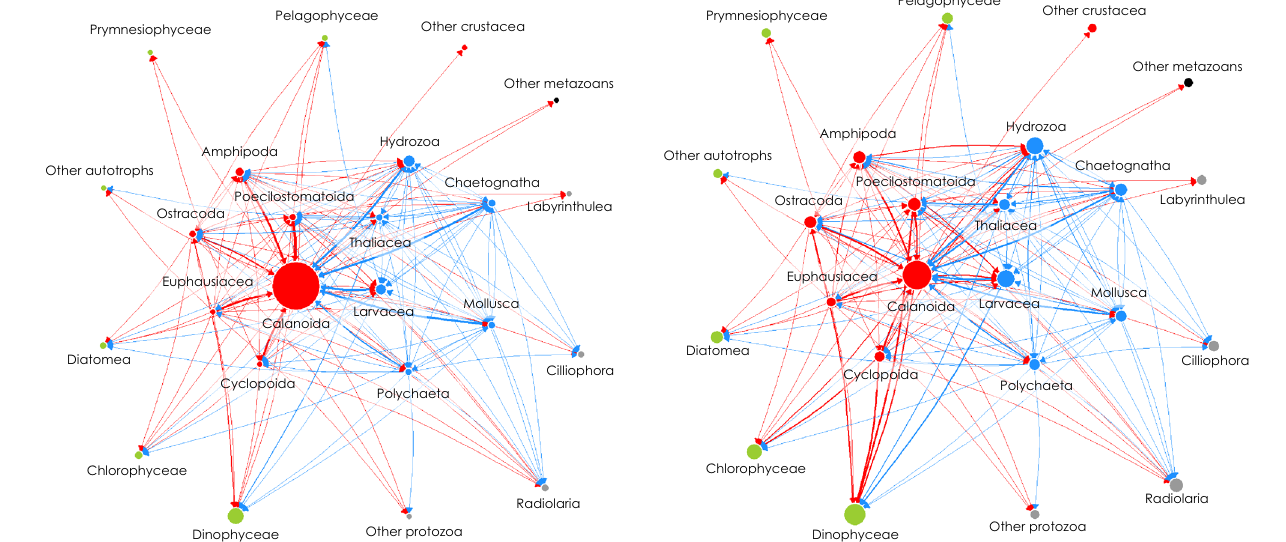
Figure 6. Trophic linkages of the plankton community in the Kuroshio of the East China Sea and its neighboring waters based on the standardized sequence reads ( a ) and appearance frequencies ( b ) of ten dominant prey OTUs in gut contents of omnivorous and carnivorous mesozooplankton groups. Arrow indicates the direction of energy flow from predator to prey. The thickness of each arrow reflects the number of relationships between prey and predator and the size of each circle corresponds to the relative importance of the trophic relationships among the other components determined with the Page Rank algorithm (https:// igraph. org/r/ doc/ page_ rank. html) from the R. Red for crustaceans, blue for gelatinous forms, green for autotrophs, gray for protozoans, black for other